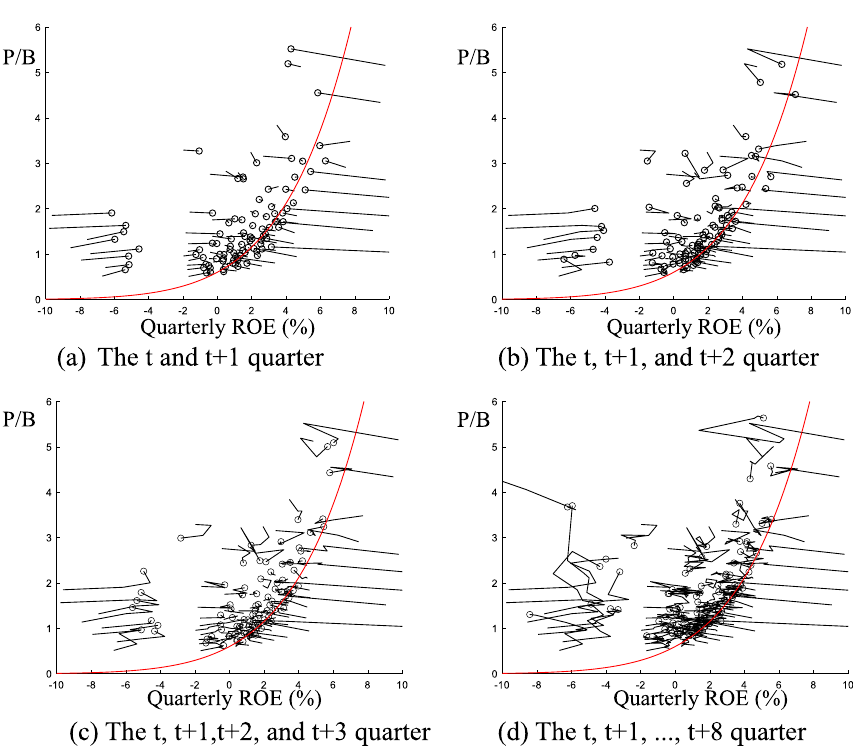
Fig. 11 The movement path of ROE (X axis) and P/B (Y axis) in the current quarter and the subsequent 1, 2, 3, and 8 quarters: Low risk